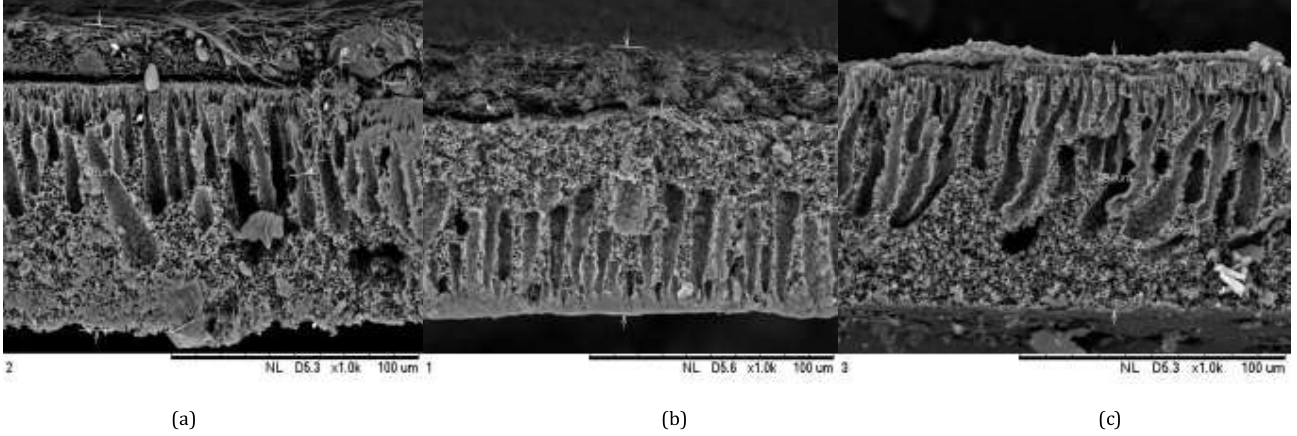
Figure 2: SEM cross section images of PVDF/e-TiO2 nanocomposite membrane a) PVDF/e-TiO2-1 bar, (b) PVDF/e-TiO2-1.5 bar and (c) PVDF/e-TiO2-2 bar 3.2 The Pure Water Flux Analysis of the PVDF/e-TiO2 Membranes